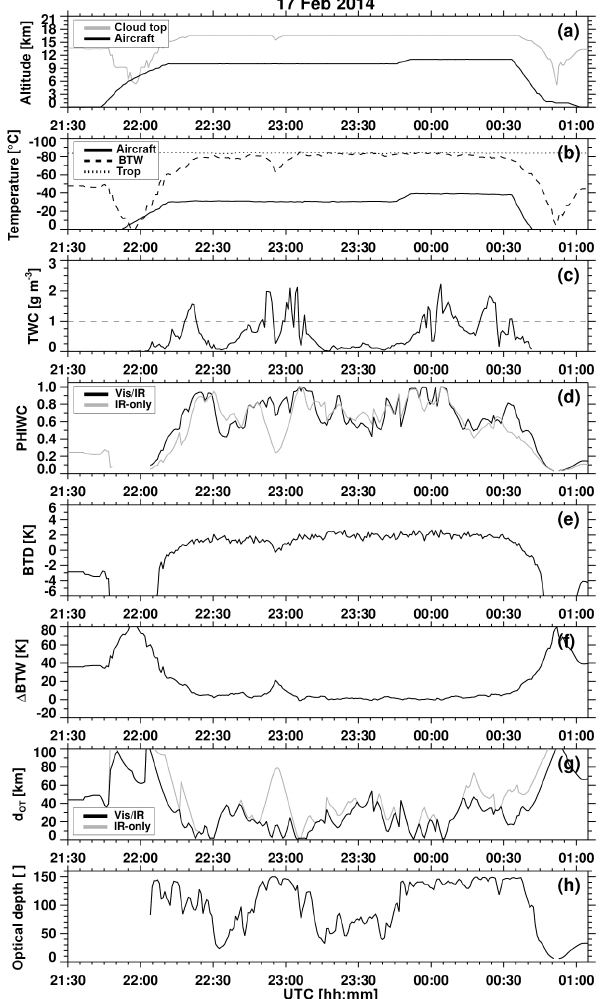
Figure 4. Time series of matched aircraft and satellite observations for Flight 22 of Darwin-2014 on 17–18 February 2014. (a) Satel- lite retrieval of cloud top height (grey) and the altitude of the Fal- con 20 (black). (b) Satellite BTW observations (dashed), MERRA tropopause temperature analysis (dotted), and aircraft static air tem- perature observations (solid). (c) In situ 45s averages of IKP2 TWC measurements. The dashed line indicates TWC = 1gm − 3 . (d) PHIWC day (black) and PHIWC night (grey), (e) WV-IRW BTD, (f) (cid:49) BTW (g) dOT VIS + IR (black) and IR-only (grey) and (h) smoothed COD. Major and minor tick marks represent half- hourly and 5min intervals,